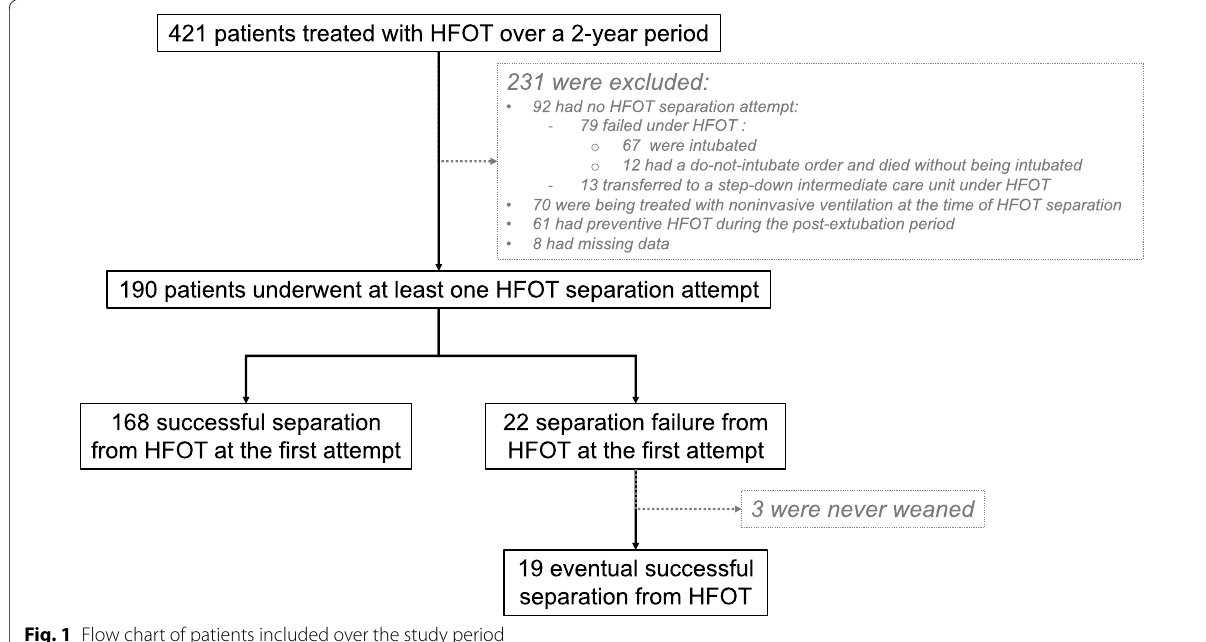
Fig. 1 Flow chart of patients included over the study period